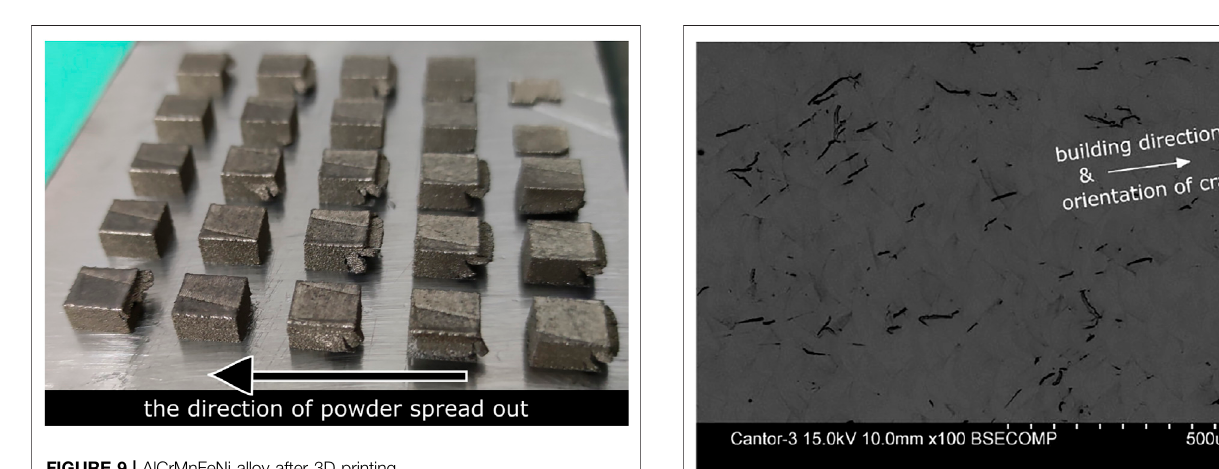
FIGURE 9 | AlCrMnFeNi alloy after 3D printing.